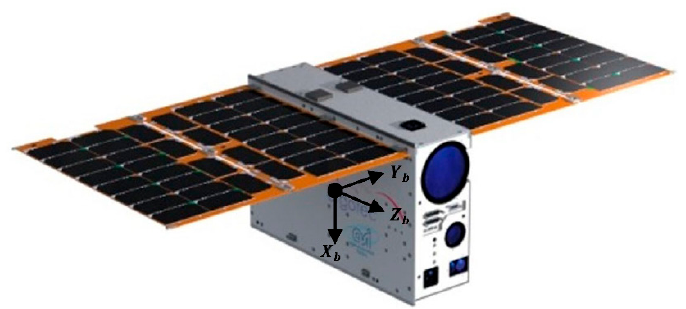
Figure 1. ArgoMoon CubeSat external view render adapted with permission from Ref. [4]. Copyright year, IEEE and the assumed body-fixed frame.